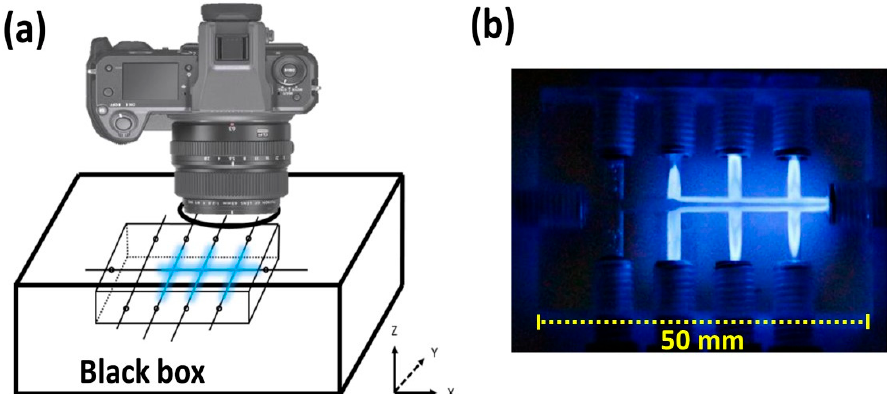
Figure 1. Schematics of the CL-CIA platform in preliminary experiments showing ( a ) camera position on top of the light-tight box and ( b ) an example of the recorded image of the platform conduit of the blue light emitted from the mixing of the chemiluminescent reagents for Co(II)-catalyzed H 2 O 2 -luminol reaction. The concentration of standard solution of Co(II) is 10 mmol L − 1 . Note: the CIA manifold is shown in more detail in Supplementary Material Figure S1.